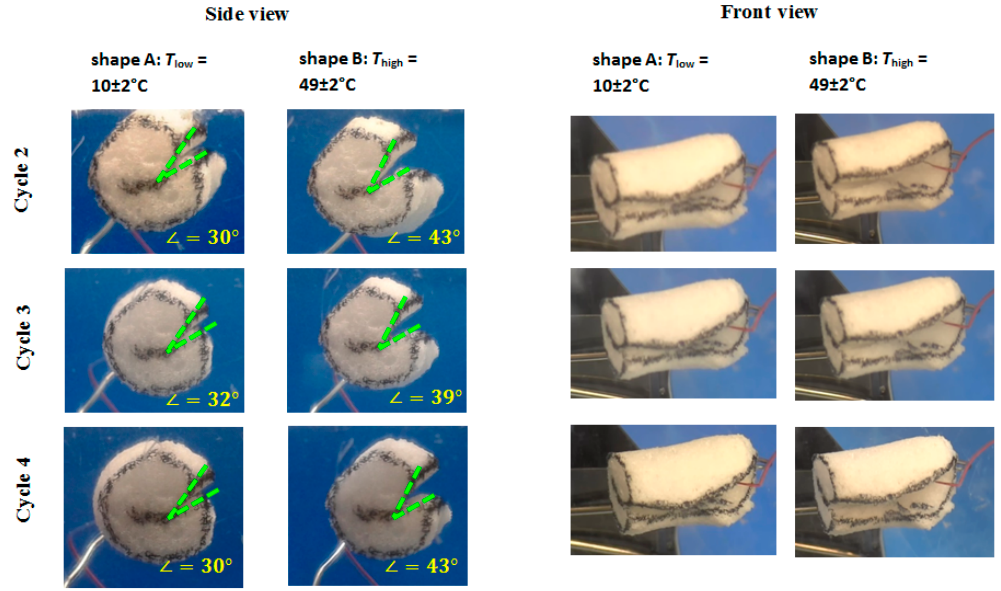
Figure 16. Load free temperature cycles of intermediate density foam.